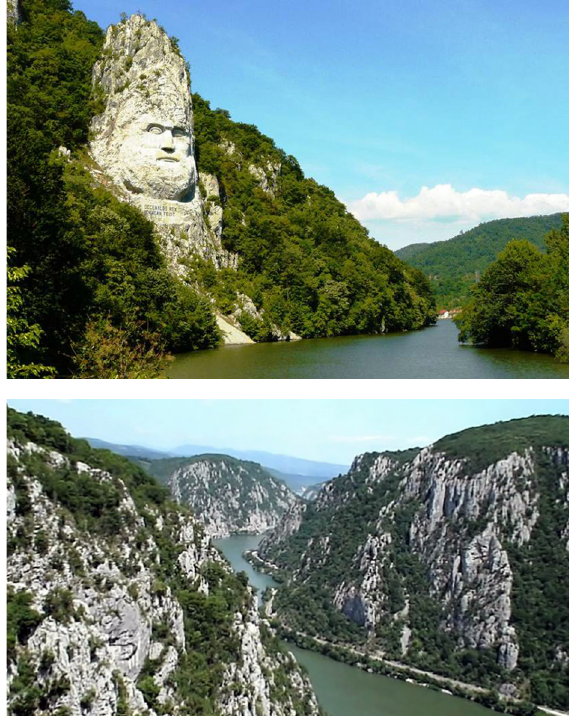
Fig. 3. The rock sculpture of King Decebal and Cazanele Mici. Source: photos taken by Andrei-Florin Băbă ț